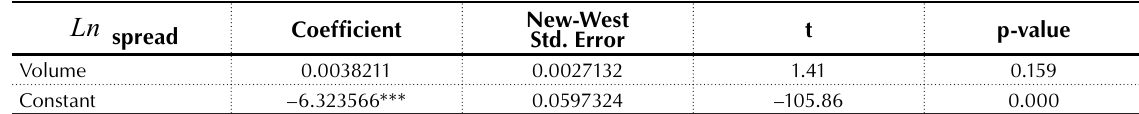
Table 4. Regression result with Newey-West standard errors Ln spread